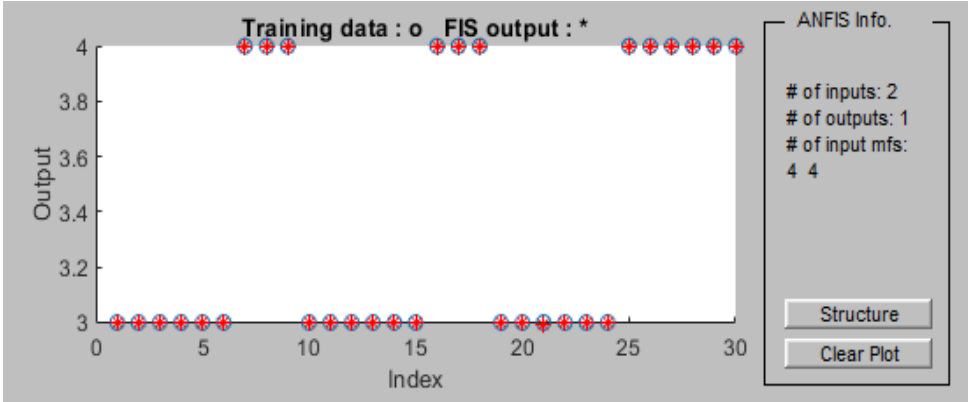
Figure 15. Training data and FIS output with two inputs and one output.